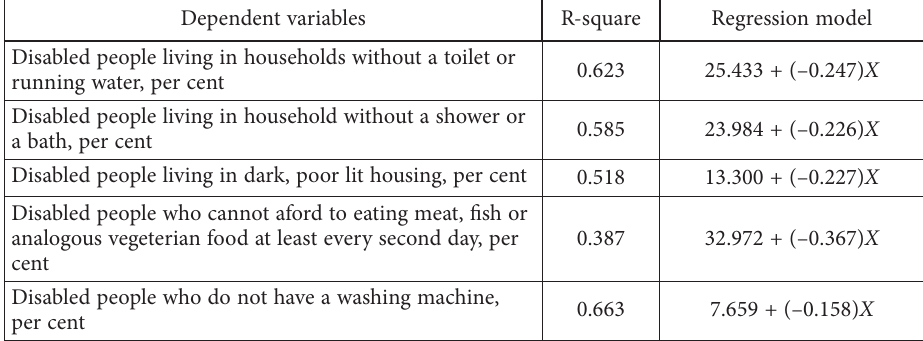
Table 1. Regression equation models for economic indicators (source: created by